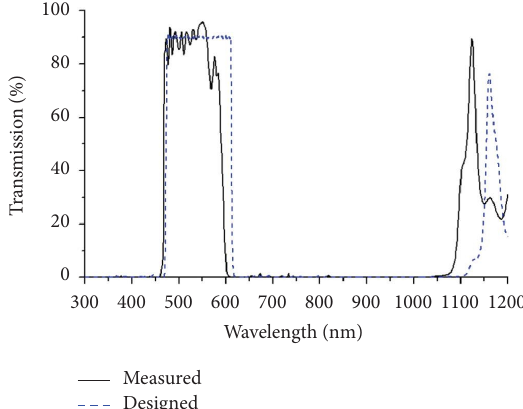
Figure 4: Designed (theoretical) and measured (experimental) transmission spectra of the bandpass flter [22].